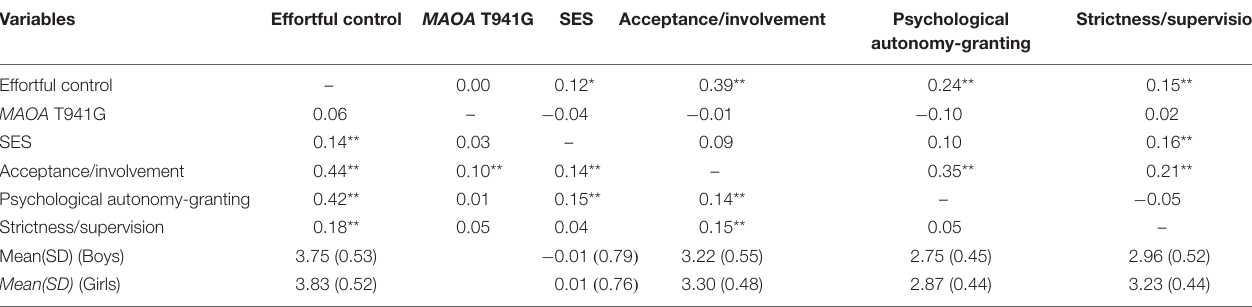
TABLE 1 | Descriptive statistics and correlations among study variables.